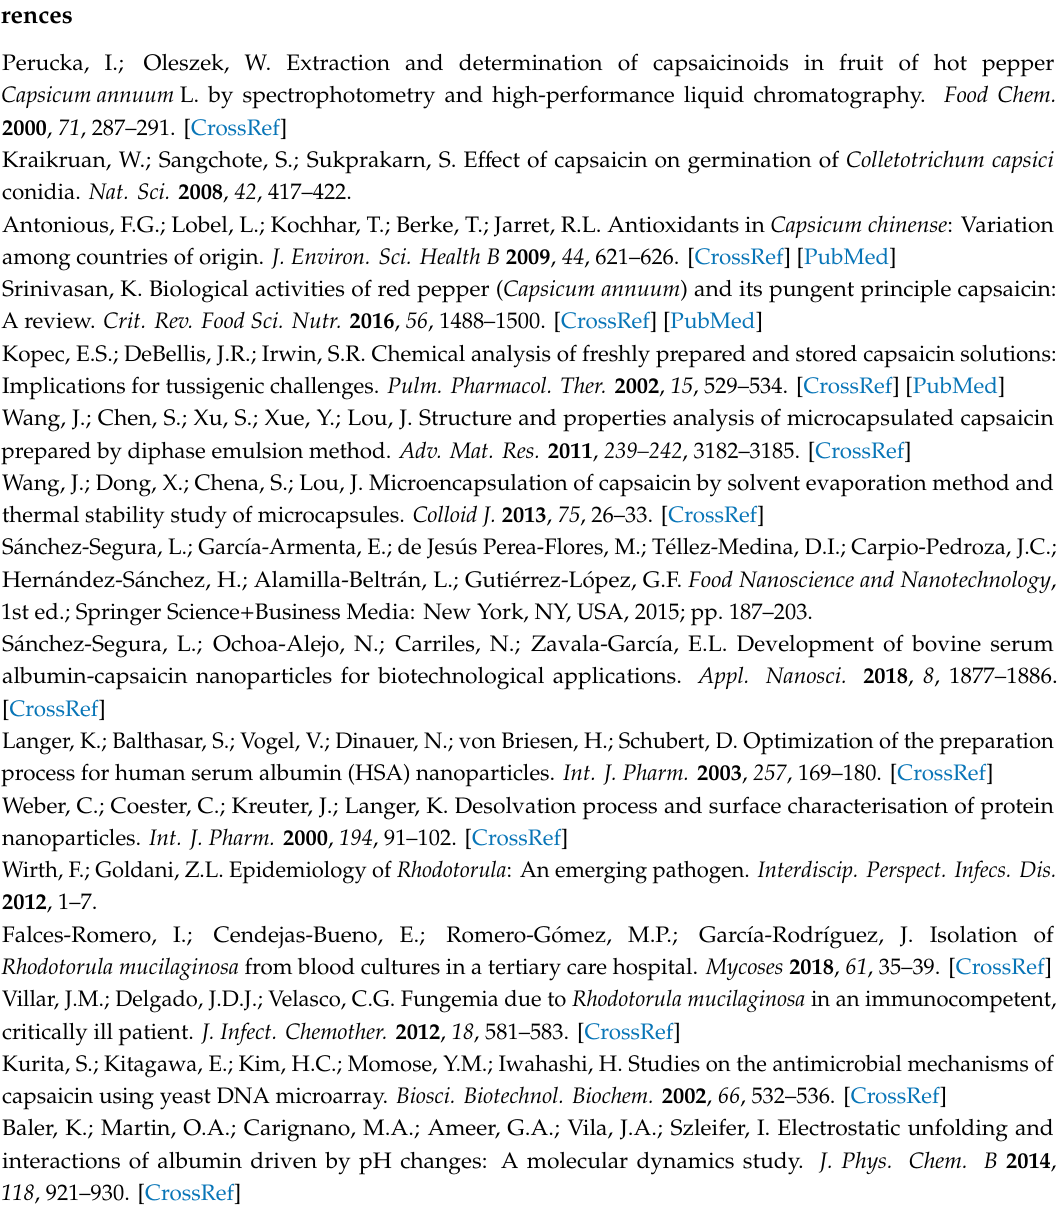
the ζ -potential. Figure S2: Electrophoretic patterns of PCR products of the 18S rRNA gene and rDNA internal transcribed spacer ITS1-4 genomic region. Lane 1, 2 negative control of each primer pair (no DNA added); lanes 3, 4 correspond to gene 18S rRNA 1500 pb amplified using primers 18S F and 18S R; lanes 5, 6, 7 and 8, a 600 pb band corresponding to ITS1-4 amplicon using universal primers ITS 1 and ITS 4. MW molecular weight 1 Kb Plus (Invitrogen). The annealing temperature in both cases was 60 ◦